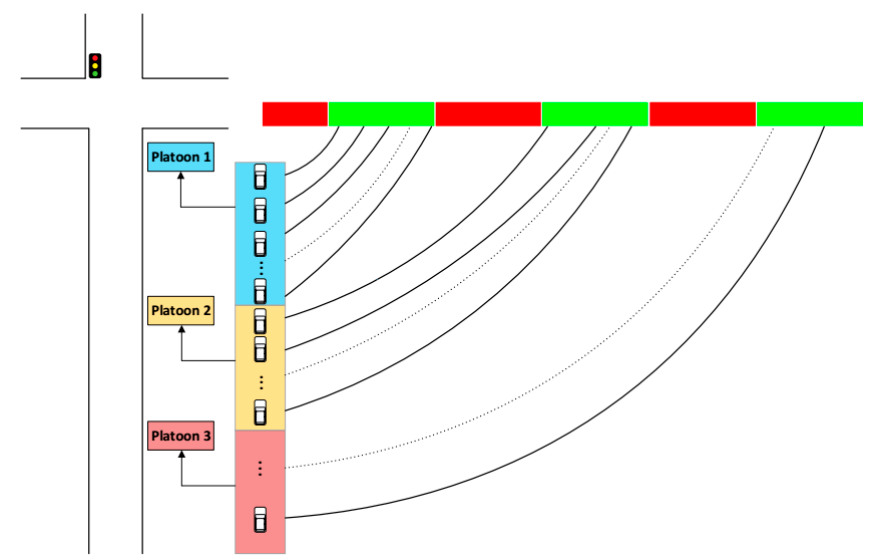
Figure 2. Distribute CAVs into platoons.